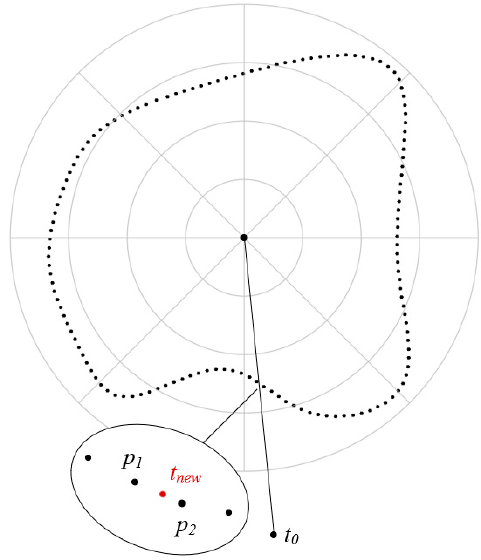
Figure 2. Schematic diagram of reference points at the opening boundary.